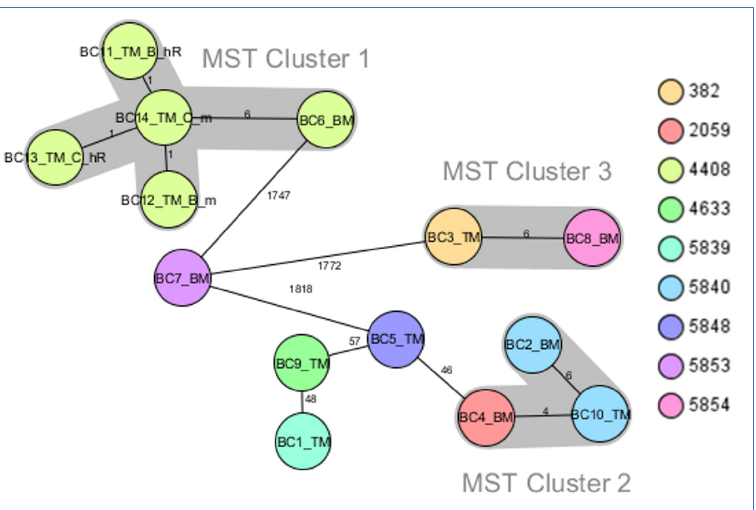
Figure 1. Minimum spanning tree for K. pneumoniae strains investigated in this study generated from cgMLST data. Ridom SeqSphere+ MST for 14 samples based on 2358 columns, pairwise ignoring missing values, logarithmic scale. Distance based on columns from K. pneumoniae sensu lato cgMLST (2358). MST cluster distance threshold: 15. Nodes colored by complex type.